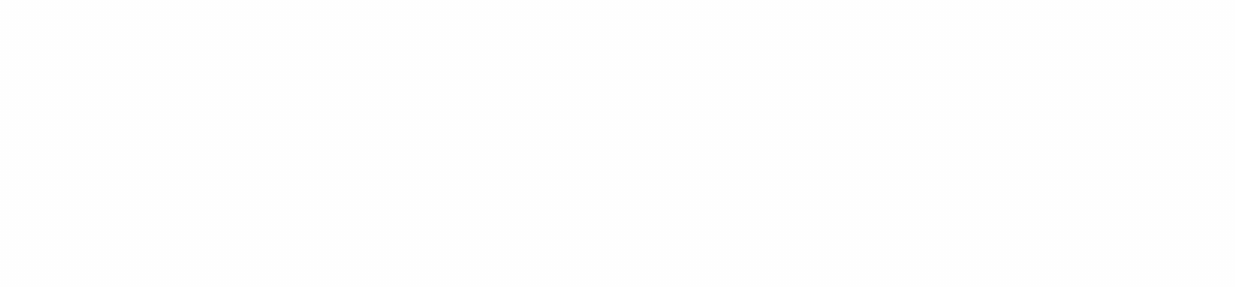
FIGURE 3 Flow cytometric detection of intracellular cytokines on a single-cell level. Living cells were isolated from MLTC or allogeneic MLC cultures after day 5 of the culture period and stained for intracellular cytokines according to Materials and Methods. Both cytokine- specific MoAb are of the same isotype and were used at the same concentrations. Thus, data for an isotype control antibody are not shown. Percentages of the respective populations are indicated in the upper right quadrant of each